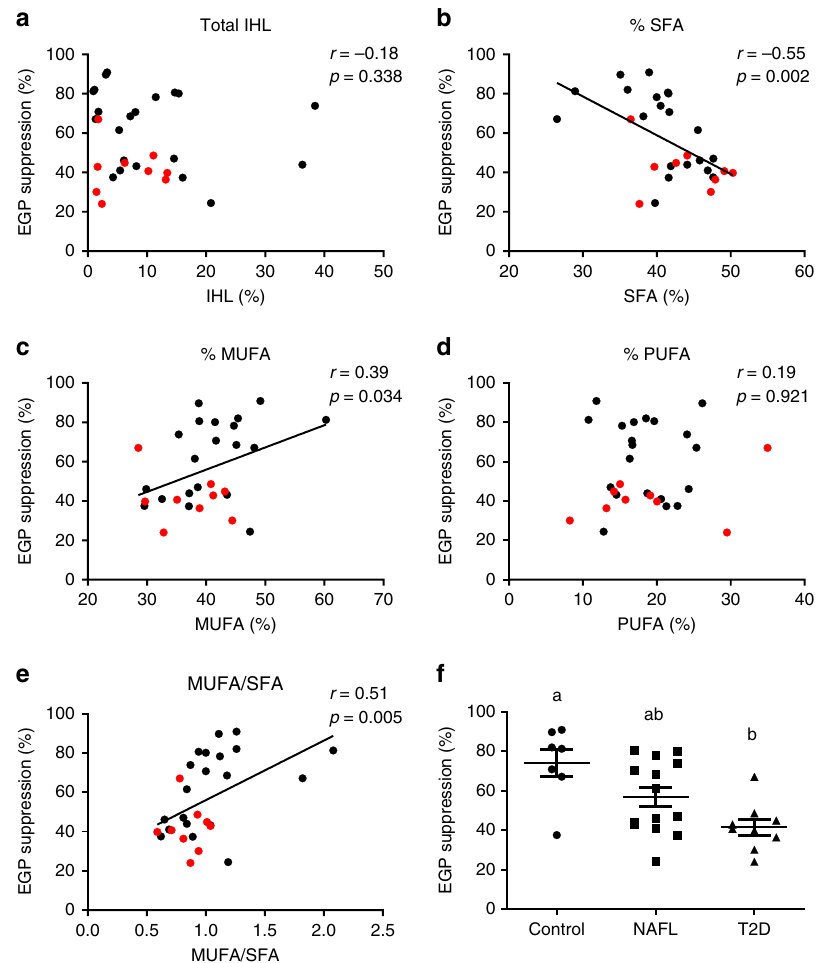
Fig. 7 The relationship between liver fat composition and hepatic insulin sensitivity. The relationship between hepatic IS (EGP suppression) and a total liver fat content, b SFA fraction, c MUFA fraction, d PUFA fraction, and e MUFA/SFA ratio in overweight and obese individuals (healthy with and without NAFL in black and patients with T2D in red, n = 30 for total liver fat content and n = 29 for the fatty acid fractions and MUFA/SFA ratio). The correlation coef fi cient is shown in the respective plots (Two-sided Spearman correlation). f EGP suppression in healthy overweight/obese without NAFL (controls, n = 7), overweight/obese with NAFL ( n = 14), and patients with T2D ( n = 9). EGP suppression in patients with T2D was signi fi cantly lower compared to controls ( p = 0.002). Data are presented as mean with error bars showing the SEM. Different letters indicate signi fi cant differences between groups (one- way ANOVA, p < 0.05). Bonferroni correction was used for post-hoc